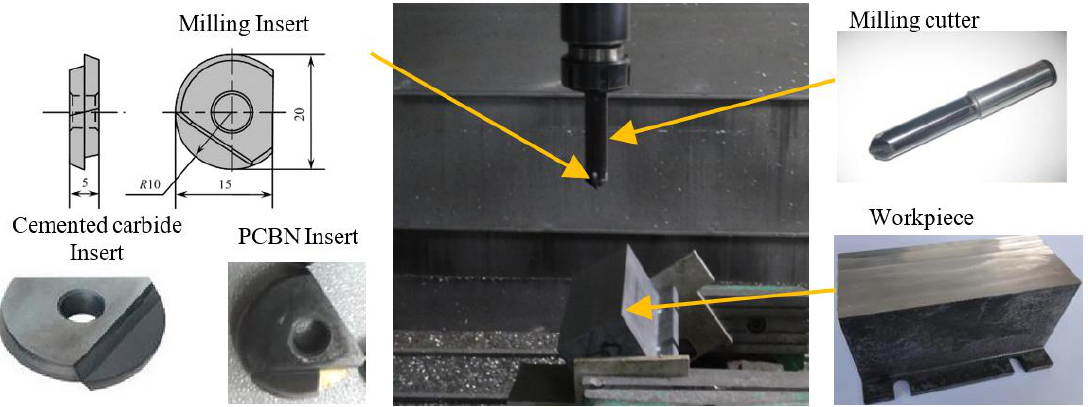
Figure 1. The experimental setup for milling test.